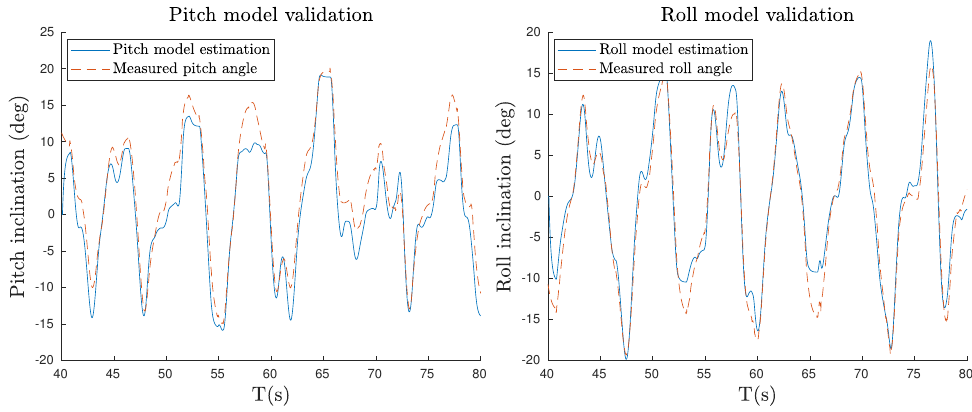
Figure 7. Validation example of the identified models for G θ ( s ) ( left ) and G φ ( s ) ( right